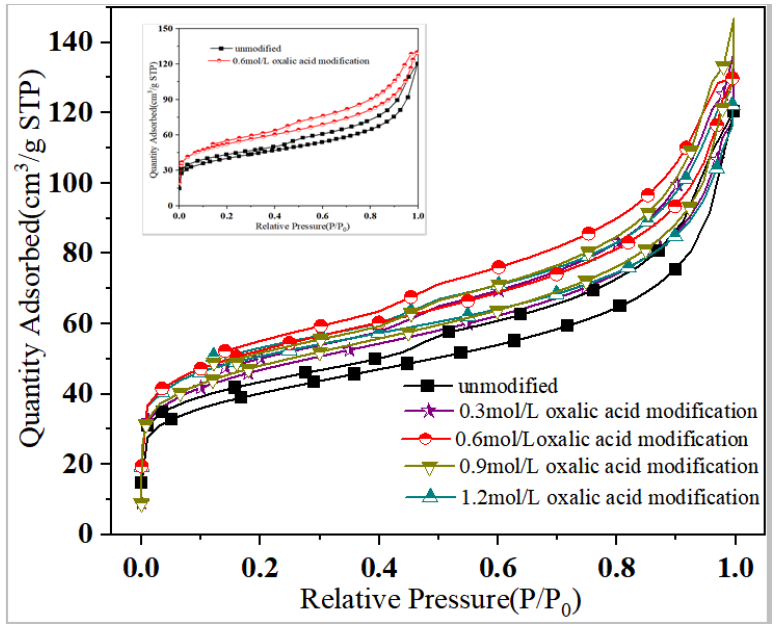
Figure 1. N 2 adsorption−desorption curves of activated carbon under different modification conditions.